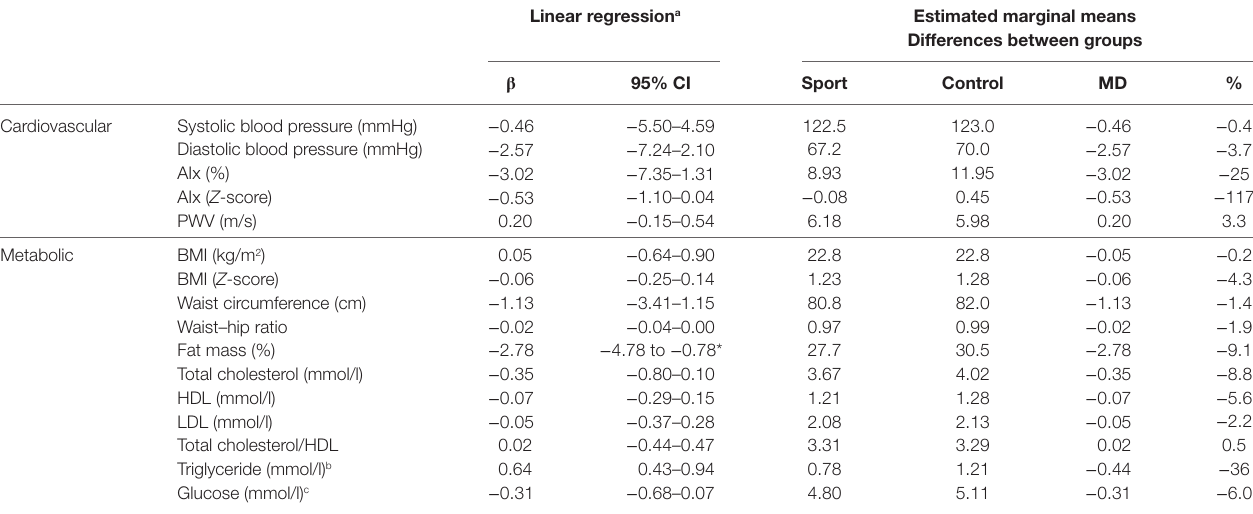
TaBlE 5 | Results from the linear regression analyses assessing the intervention effect on cardiometabolic health.